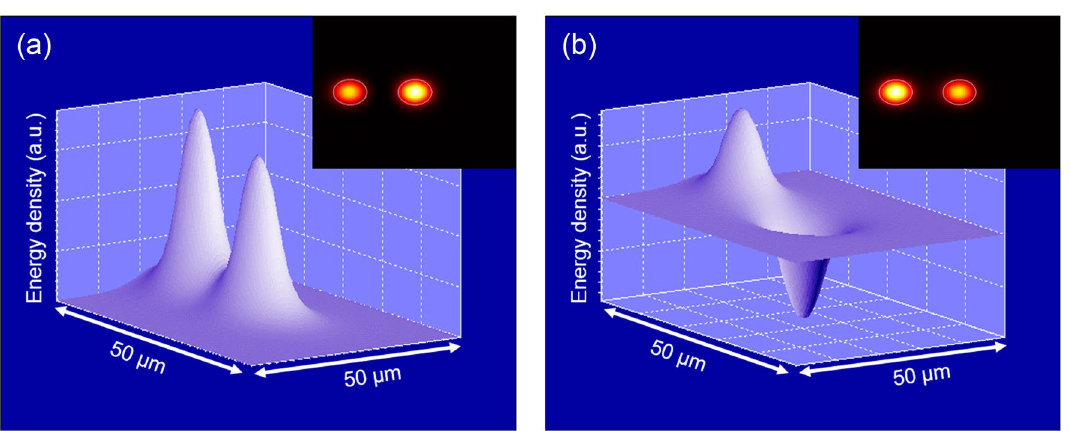
Figure 3. Simulations of the 3D and 2D profiles of the two coupled orthogonal supermodes excited in the TCF. In ( a ) the supermode SP 01 is shown, and in ( b ) the supermode SP 02